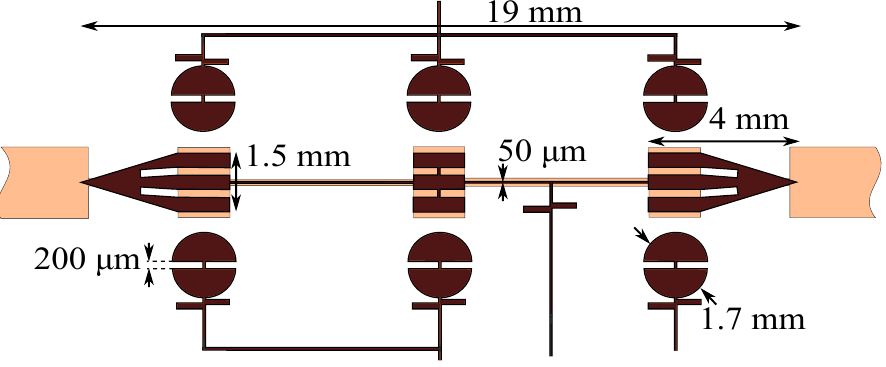
Figure 54. Schematic of the electrode